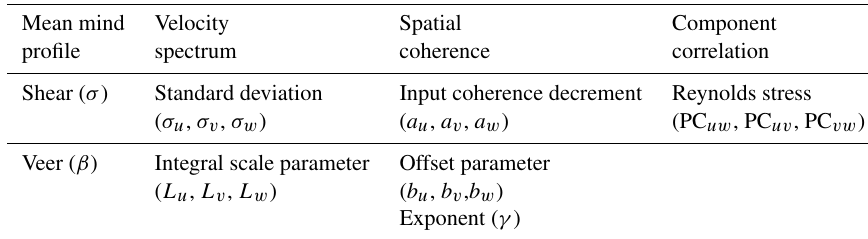
Table 2. Wind-inflow condition parameters (18